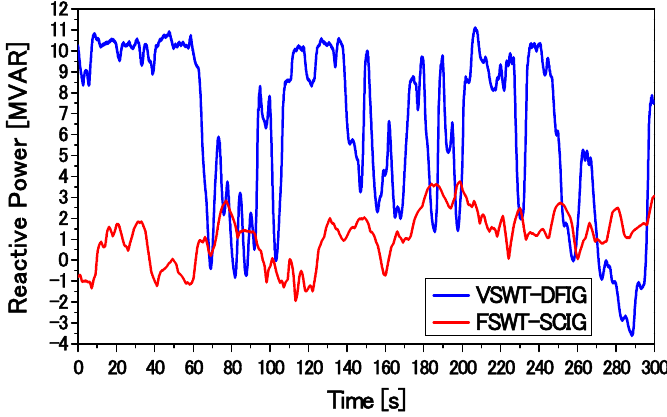
Figure 33. Reactive power output of wind generators.